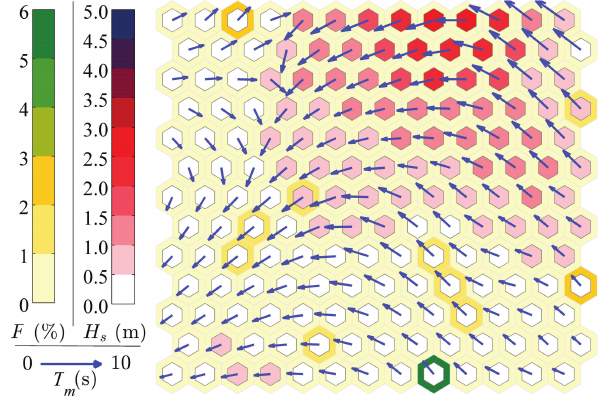
Figure 4. Single-step SOM output map. H s : inner hexagons’ color, T m : vectors’ length, θ m : vectors’ direction, F : outer hexagons’ color. Mean quantization error: 0.06; topographic error: